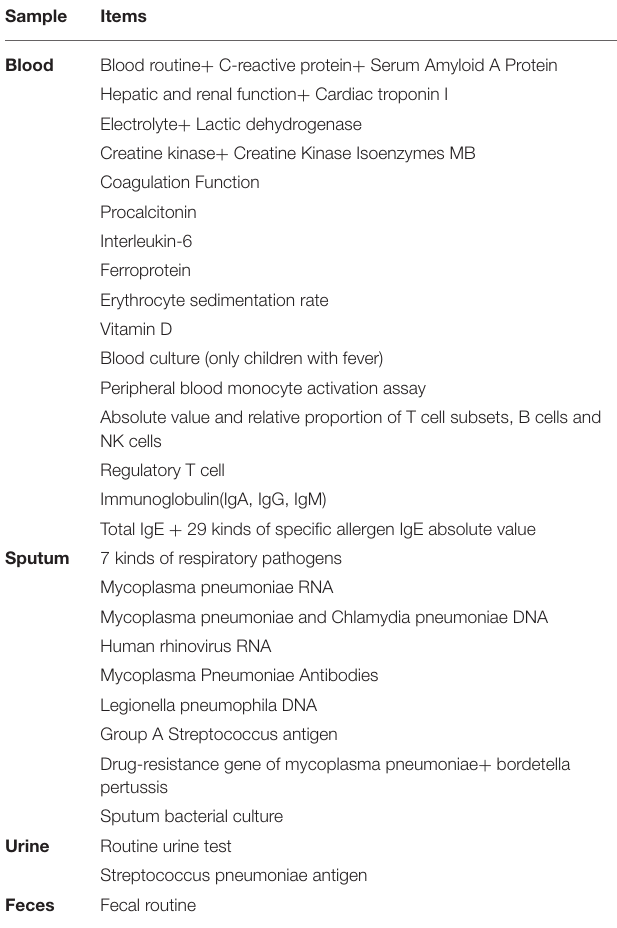
TABLE 1 | The package of auxiliary examinations for children with lower respiratory tract infections (LRTIs).